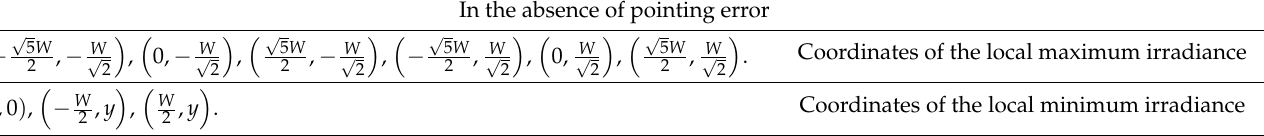
Coordinates of the local minimum irradiance